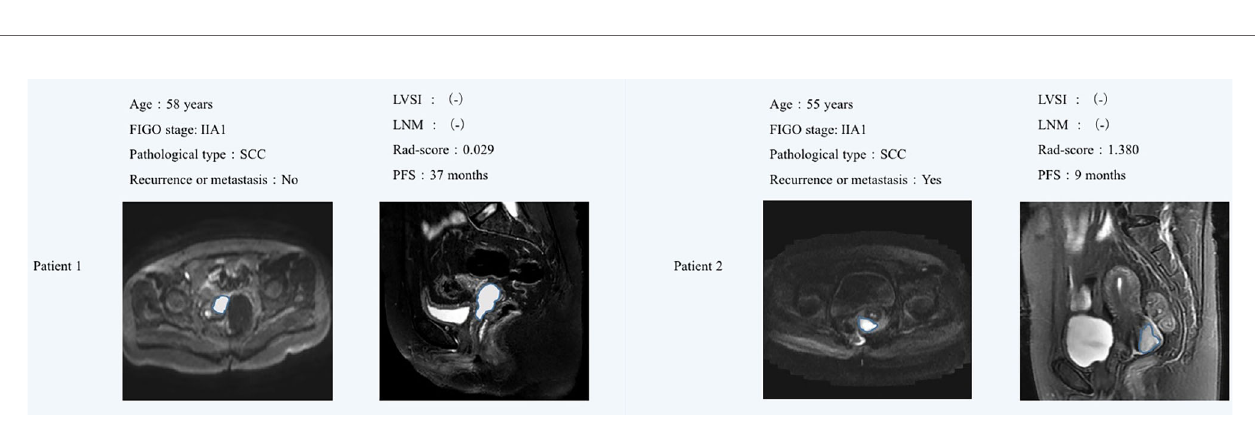
FIGURE 3 | MR images showed that the sagittal T2WI and axial DWI lesions were cervical cancer. Although patient 1 and patient 2 had similar clinicopathological characteristics, their Rad-score were signi fi cantly different. Patient 1 did not fi nd obvious signs of recurrence or metastasis after 37 months of postoperative follow- up, while the Patient 2 relapsed 9 months after surgery. The Rad-score of patient 2 was signi fi cantly higher than that of patient 1. FIGO, International Federation of Gynecology and Obstetrics; LVSI, lymph vascular space invasion; LNM, lymph node metastasis; SCC, squamous cell carcinoma; PFS, progression-free